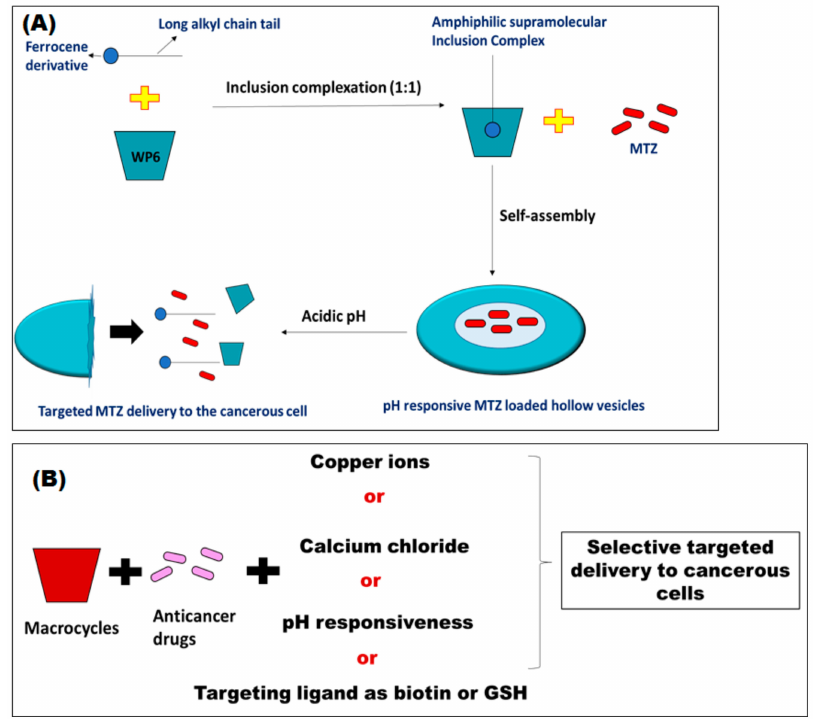
Figure 3. ( A ) Schematic diagram representing the design of pH responsive mitoxantrone (MTZ) loaded supramolecular vesicles, ( B ) Host-Guest responsive complexes. GSH: